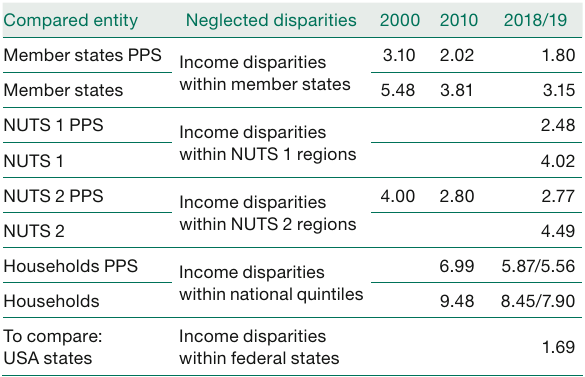
Quintile ratios of income in the